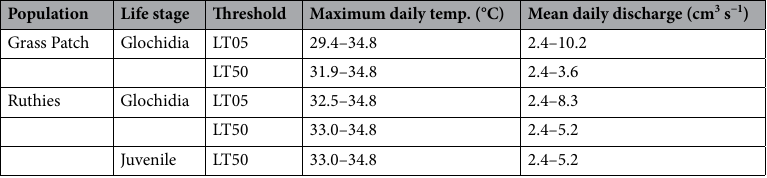
Table 2. Water temperature and discharge data for temperature exceedance events for the LT05 and LT50 thresholds (24-h glochidia and 96-h juvenile) for two subpopulations of Popenaias popeii in the Devils River. Ranges are presented for maximum daily temperature and mean daily